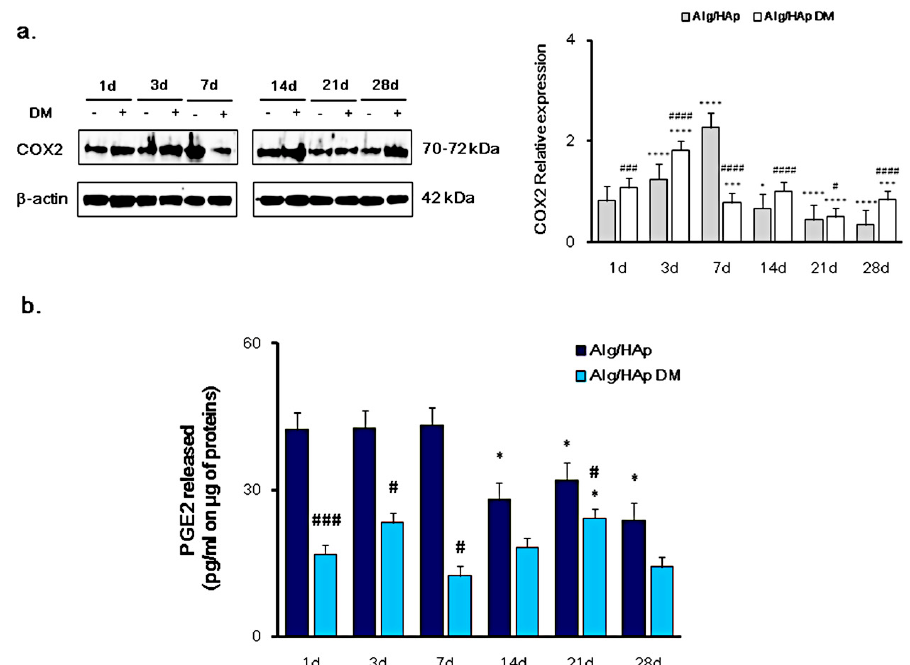
Figure 1. Cyclooxygenase-2 / prostaglandin 2 COX2 / PGE2 pathway modulation in dental pulp stem cells (DPSC) growth onto alginate / hydroxyapatite (Alg / HAp) sca ff olds. ( a ) Typical results of COX2 protein expression by Western blotting of three independent experiments. β -actin was used as a protein content marker. The bar graph shows densitometric values expressed as the mean percentage ± Standard Error of the Mean (SEM) ( n = 3) of integrated optical densities of protein bands normalized to β -actin. * p < 0.05 between Alg / HAp at 14 days and Alg / HAp at one day; *** p < 0.005 between Alg / HAp with or without di ff erentiation medium (DM) at seven and 28 days and Alg / HAp at one day; **** p < 0.001 between Alg / HAp with or without DM at three days and Alg / HAp at one day; # p < 0.05 between Alg / HAp with and without DM at 14 days; ### p < 0.005 between Alg / HAp with and without DM at one day; #### p < 0.001 between Alg / HAp with and without DM at three, seven, and 28 days. ( b ) The bar graph displays the quantification of PGE2 released in pg / mL normalized to the protein content ( µ g / sample). Values are expressed as means ± SEM ( n = 3). * p < 0.05 between Alg / HAp at 14, 21, and 28 days and Alg / HAp at one day; * p < 0.05 between Alg / HAp with DM at 21 days and Alg / HAp at one day; # p < 0.05 between Alg / HAp with and without DM at three, seven, and 21 days; ### p < 0.005 between Alg / HAp with and without DM at one day.